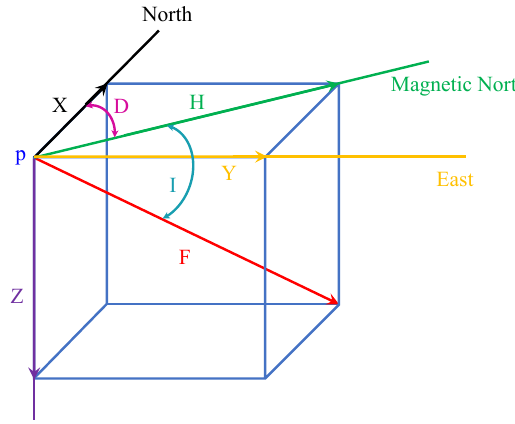
Figure 1. The components of the magnetic field at a given point p on earths